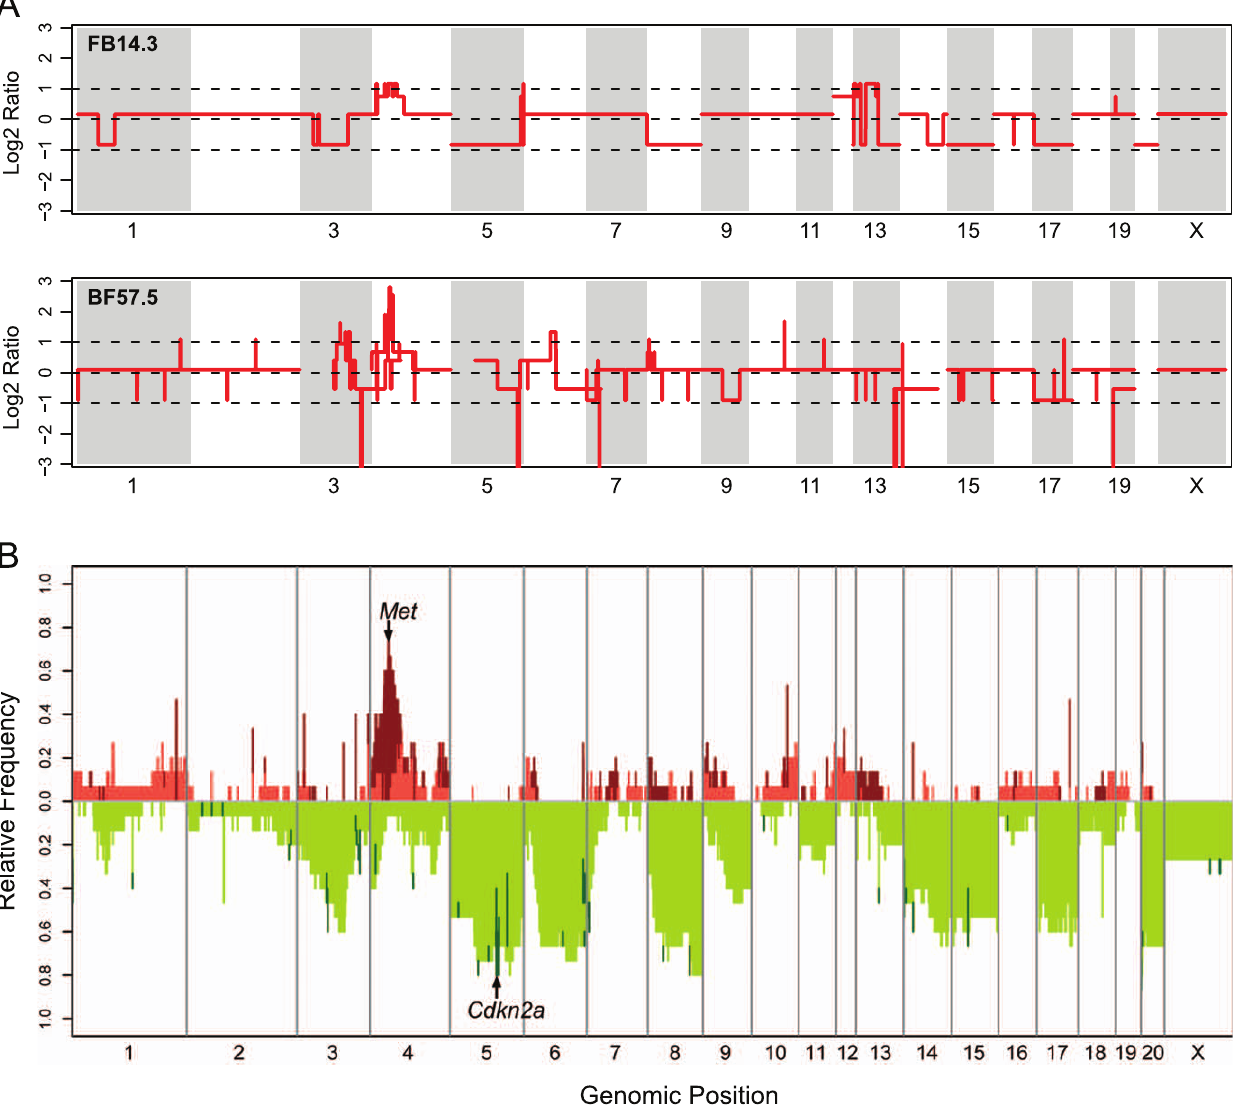
Figure 1. Genome-wide views of DNA copy number alterations in Fe-NTA induced rat renal cell carcinomas (RCCs). (A) Representative array-based CGH profiles from two RCC tumors. The red lines show log2 ratios of the estimated copy number over the inferred cancer ploidy versus the genomic position for all of the CGH microarray probes. (B) Frequency distribution of copy number aberrations across the whole rat genome. The relative frequencies of amplification (dark red), gain (tomato), loss (green yellow) and homozygous deletion (dark green) within 13 RCC tumors and two RCC cell lines are plotted at each genomic position. Two cancer-related loci, Met and Cdkn2a , which were most frequently affected by copy number aberration are indicated by the